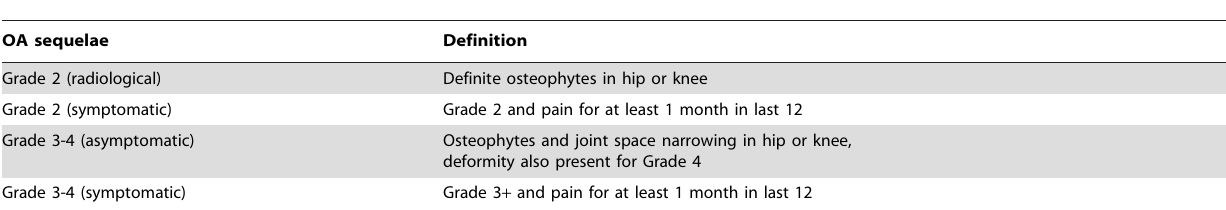
Table 2. Case definition and